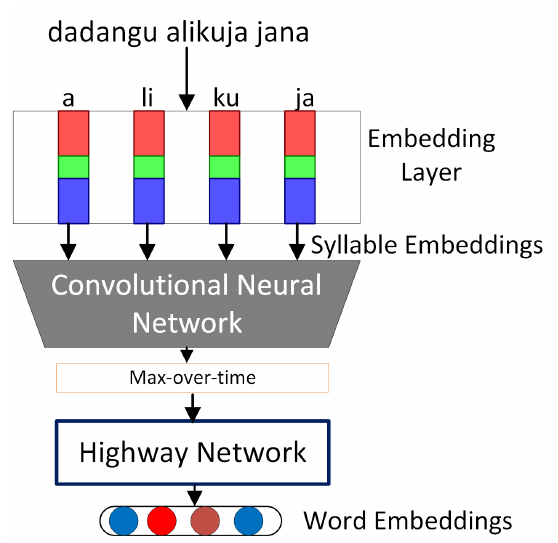
Figure 1. The Architecture of WEFSE demonstrating how the Swahili word alikuja is split into its respective syllables and subsequent composition of the embeddings. The convolutional layer provides the composition function to generate the word